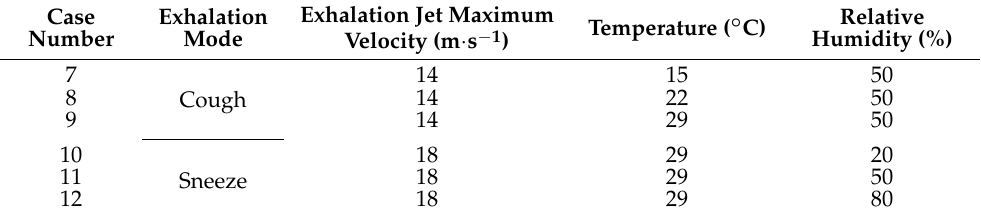
Table 4. Characteristics of the cough and sneeze cases for sensitivity investigations.